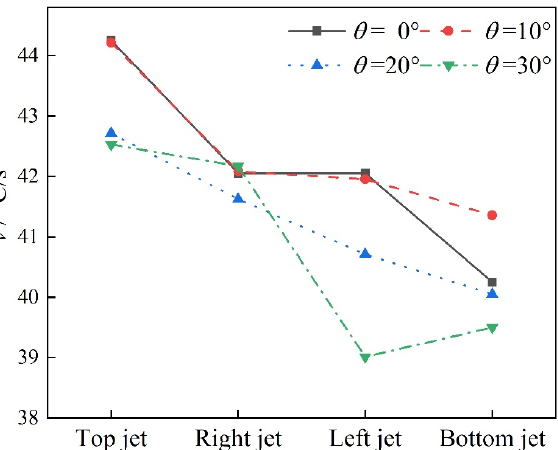
Figure 11. Distribution of average cooling rate ( v ) of steel tube with jet inclination at different jet positions.